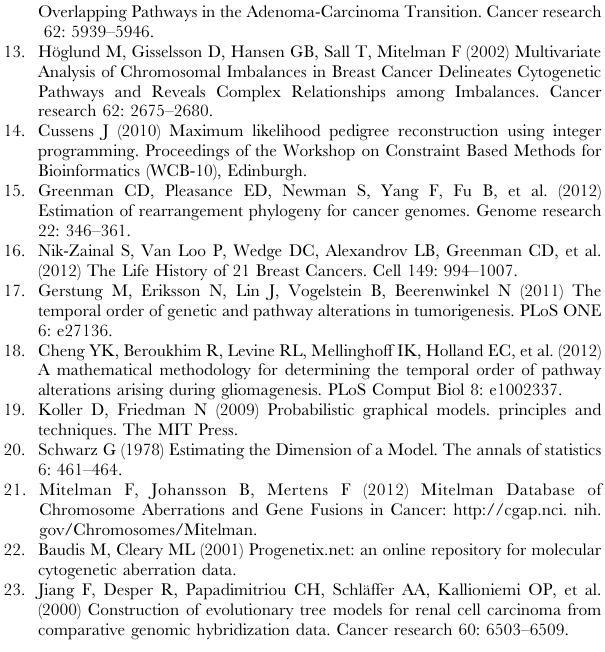
Figure S1 The percentage of bad edges for various values of e and k ~ 2 for MPN/SMPN, and General PNs for BC learned by DiProg. Figure S2 The percentage of bad edges for various values of e and k ~ 4 for MPN, SMPN, and General PNs for BC learned by DiProg. Table S1 Performance of the algorithm with synthetic data for k ~ 2 . Table S2 Performance of the algorithm with synthetic data for k ~ 3 . Table S3 False discovery rate and false negative rate values for synthetic data with k ~ 2 . Table S4 False discovery rate and false negative rate values for synthetic data with k ~ 3 . Table S5 Percentage of bad edges and the BIC scores of the MPNs learned from the BC data in [ 13 ] with DiProg.